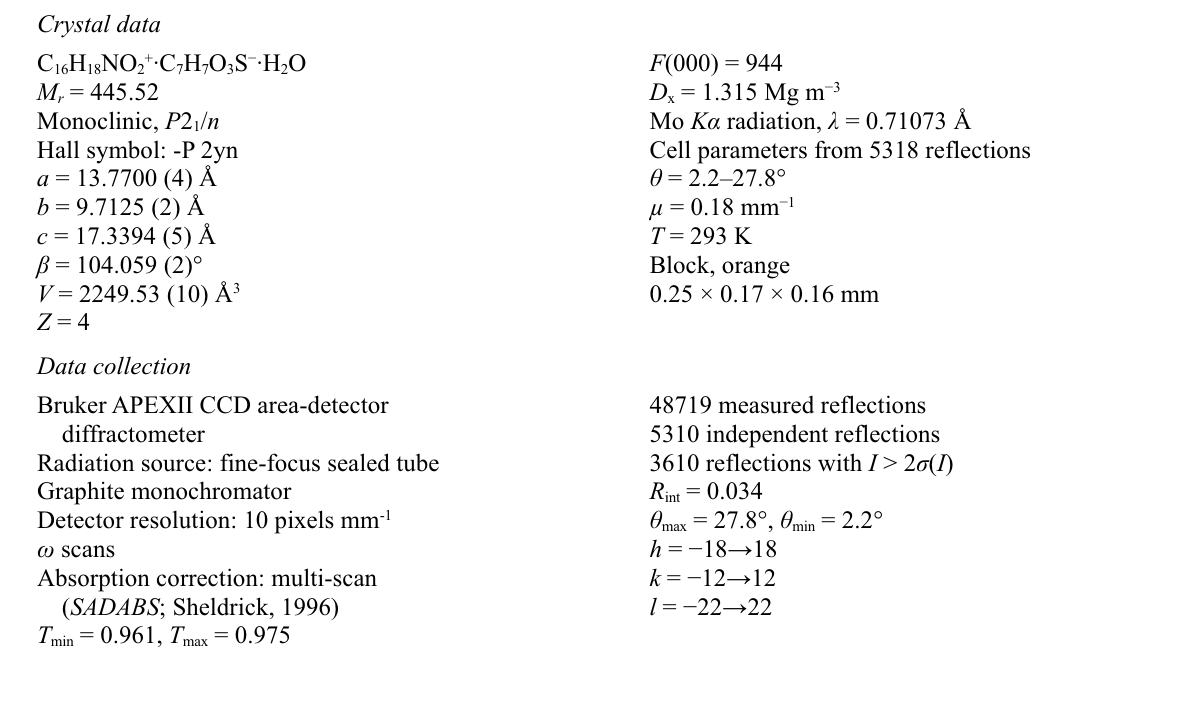
Figure 2 2. π — π interactions (dotted lines) in the title compound. Cg denotes ring centroid. [Symmetry code: (i) -x+1, -y, -z+1; (ii) x, y-1, z; (iii) x, y+1, z; (iv) -x+1, -y+1, -z+1.] 4-(3-Ethoxy-4-hydroxystyryl)-1-methylpyridinium tosylate